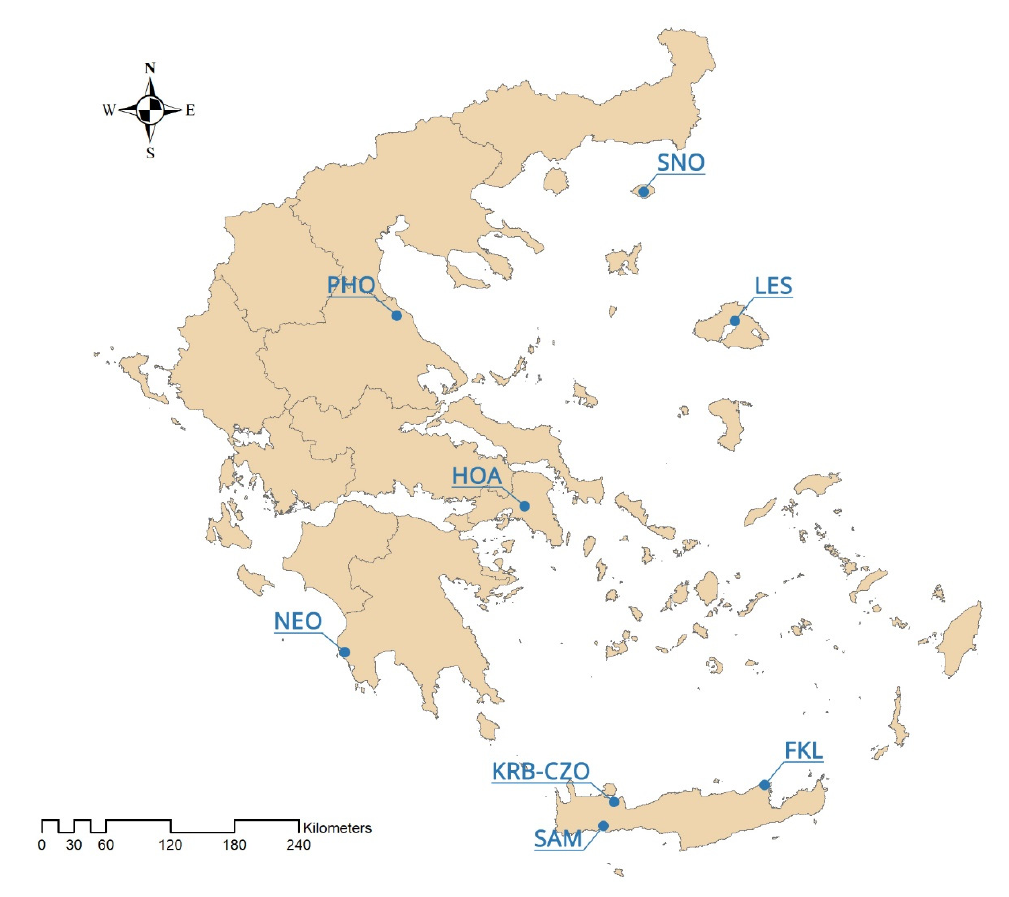
Figure 1. The location of the eight LTER sites.